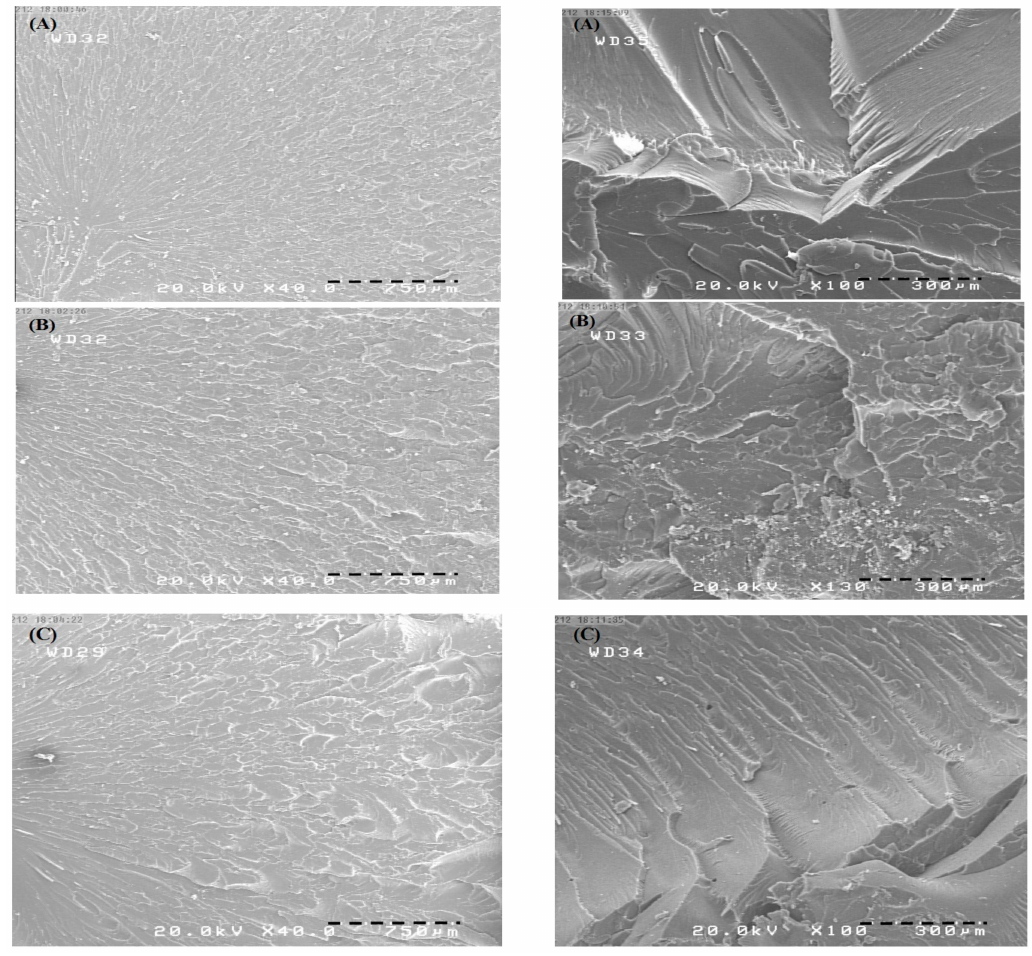
Figure 8. SEM images of the fracture surfaces of the various samples at different magnifications (( A ) 9.9 wt % curing agent; ( B ) 12.9 wt % curing agent; and ( C ) 15.9 wt % curing